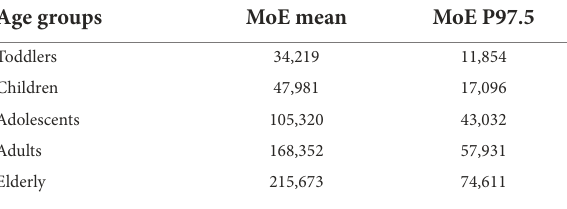
TABLE 5 Mean and 97.5th percentile (P97.5) margin of exposure (MoE) values of the different age groups for 2019–2022 calculated with a semi-deterministic method.